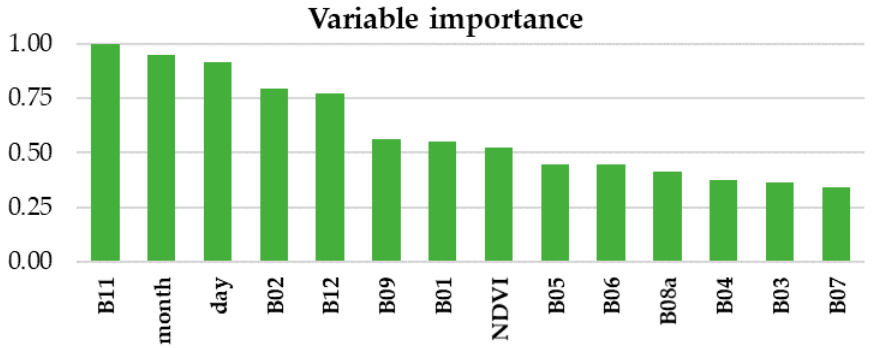
Figure 8. Variable importance barplot expressed through the Mean decrease Gini measure.